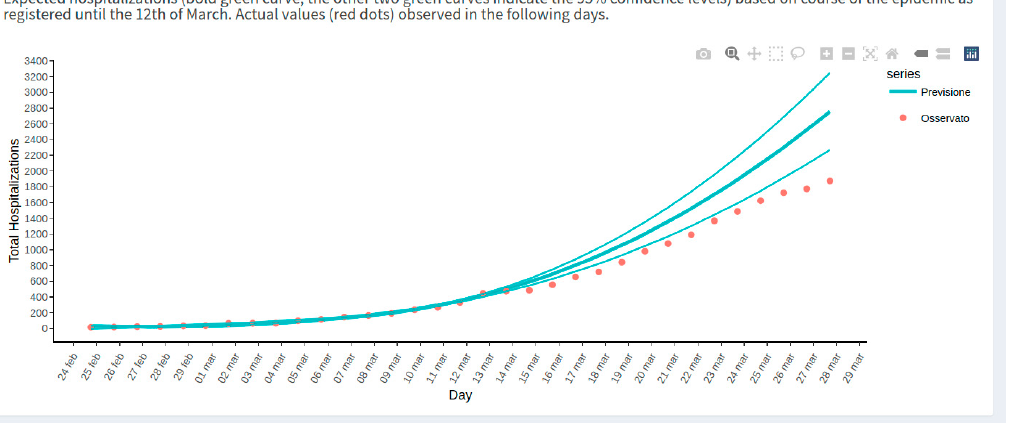
Figure 3. One example of the content of the Highlights section (namely, the possible effect of the health policies implemented by the Veneto region) as displayed in the main body of the COVID-19 pandemic application.